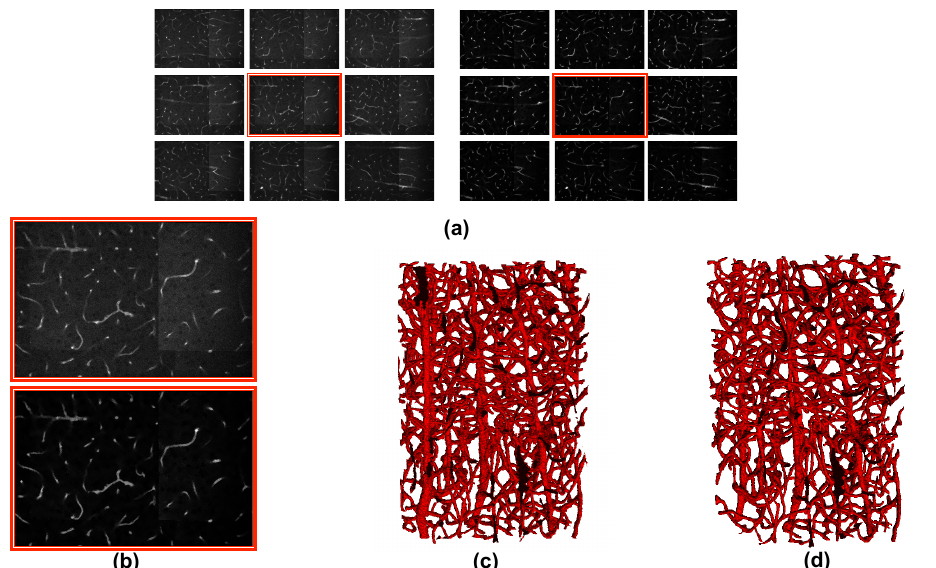
Figure 3. Image treatment: ( a ) Original images ( left ) and result of filtering ( right ). ( b ) Zoomed versions extracted from ( a ). Original slice ( up ), filtered slice ( down ). ( c ) Segmented volumen. ( d ) Result after artifacts